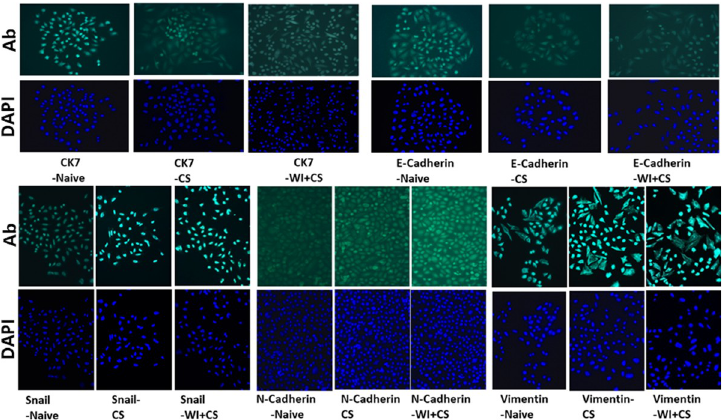
Fig 3. Immunocytochemical (ICC) staining of the epithelial cell markers. Human cholangiocyte-specific protein staining (upper panels) includes both CK7 and E-cadherin from groups of cells that include Na ï ve cells without DCD ischemia, from cells with 24 hour exposure to cold storage (CS), and from cells exposed to both cold storage and 60 minutes of warm ischemia (WI). Each antibody (Ab) specific stain is paired with the same cells stained with the nuclear stain DAPI (blue images). For the epithelial markers, the magnitude of the specific staining DECREASES as the degree of DCD ischemia increases (Na ï ve to CS to CS+WI). The bottom groups of cells are similar to the top except these cells were stained for the mesenchymal specific markers SNAIL, N-cadherin, and Vimentin. Opposite to the pattern seen with epithelial markers, the mesenchymal specific markers are shown to INCREASE in staining intensity as the level of DCD ischemic stress increases (Na ï ve to CS to CS+WI). These protein expression patterns are consistent with cells undergoing an epithelial-to-mesenchymal transition (EMT). Magnification is 200x.